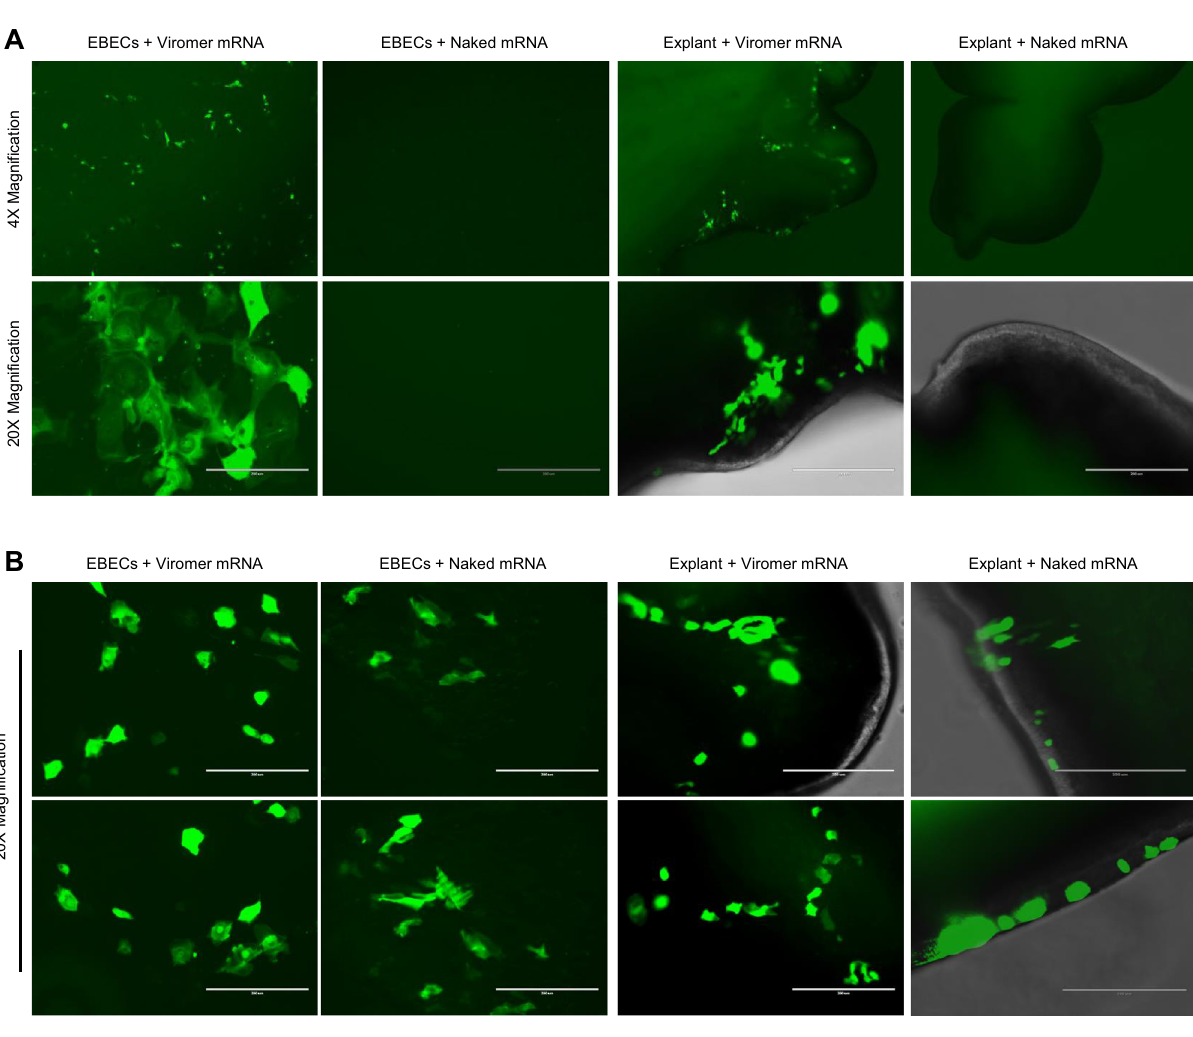
Figure 1. Transfection of cultured equine respiratory tissues using eGFP mRNA delivered as an aerosol of either naked mRNA or mRNA formulated with Viromer. (A) Transfection and eGFP expression of cultured equine bronchial epithelial cells (EBECs) and bronchial explants submerged in cell media, detected by fluorescent microscopy after 24 h incubation at 37 °C, was successful using Viromer transfection agent but failed when naked mRNA was delivered to EBECs or explants in media. The experiment was performed in duplicate, using 0.2 µg mRNA in each well of EBECs and 0.8 µg mRNA in each well of bronchial explants. Transfection with mRNA solution delivered by aerosolization was performed 48 h after establishing EBECs in culture and 72 h after establishing bronchial explant cultures. Each condition is shown at low magnification (upper row ×4, bottom row ×20 with scale bar 200 µm). All cultured tissues were derived from the same horse. (B) Transfection of cultured equine bronchial epithelial cells (EBECs) and bronchial explants using aerosolized mRNA expressing eGFP with media removed. Conditions were the same as in (A) , except that media was removed and cultured tissues were washed twice with warmed phosphate-buffered saline prior to mRNA delivery; the mRNA solutions were delivered to cultured tissues using an aerosolizer device, incubated at 37 °C for 10 min, and then culture media was returned for subsequent incubation. All cultured tissues were derived from the same each foal, the control side was aerosolized with the same volume of water as the treated side. The rationale for using 2 different volumes was to examine whether dilution of mRNA in a larger volume (as will occur with nebulization) reduced the efficacy of transfection. The endoscope was passed to the carina and then passed into each mainstem (primary) bronchus. A bifurcation of a secondary bronchus was identified and probed with the FCFM system to document the absence of signal; the FCFM system was calibrated before use to improve accu- racy. After completing the procedure in 1 mainstem bronchus, the process of signal detection was repeated in the mainstem bronchus of the other side of the horse. Then, we aerosolized the origin of a secondary mainstem bronchus on the side assigned to water (performed before mRNA to avoid cross-contamination via the biopsy channel of the endoscope), followed by aerosolization of naked eGFP mRNA onto the origin of a secondary mainstem bronchus of the other side of the horse. Endoscopic images were collected to allow us to map back to the site of transfection on each side of the horse. Endoscopy was repeated at 8, 24, 48, and 96 h after aerosoliza- tion in both foals. At each examination, fluorescence microscopy was performed transendoscopically using the